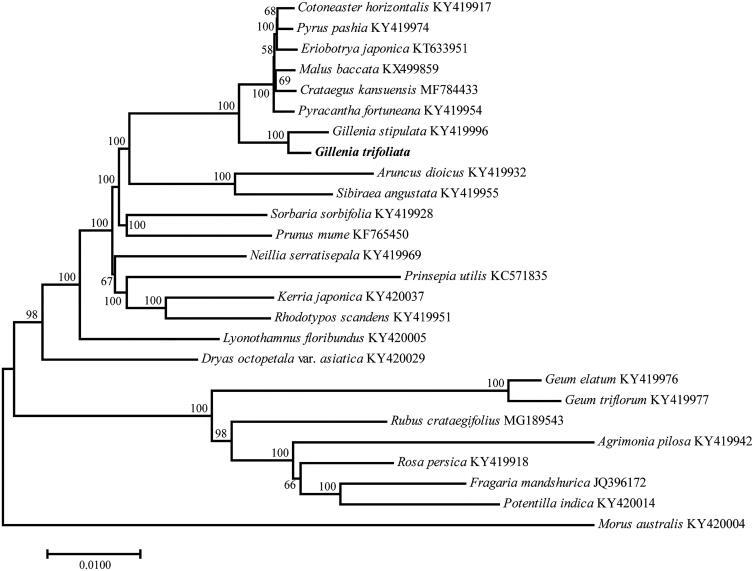
Phylogenetic tree reconstruction of 26 taxa using maximum likelihood based on complete chloroplast genome sequences. Bootstrap support values are given at each node.